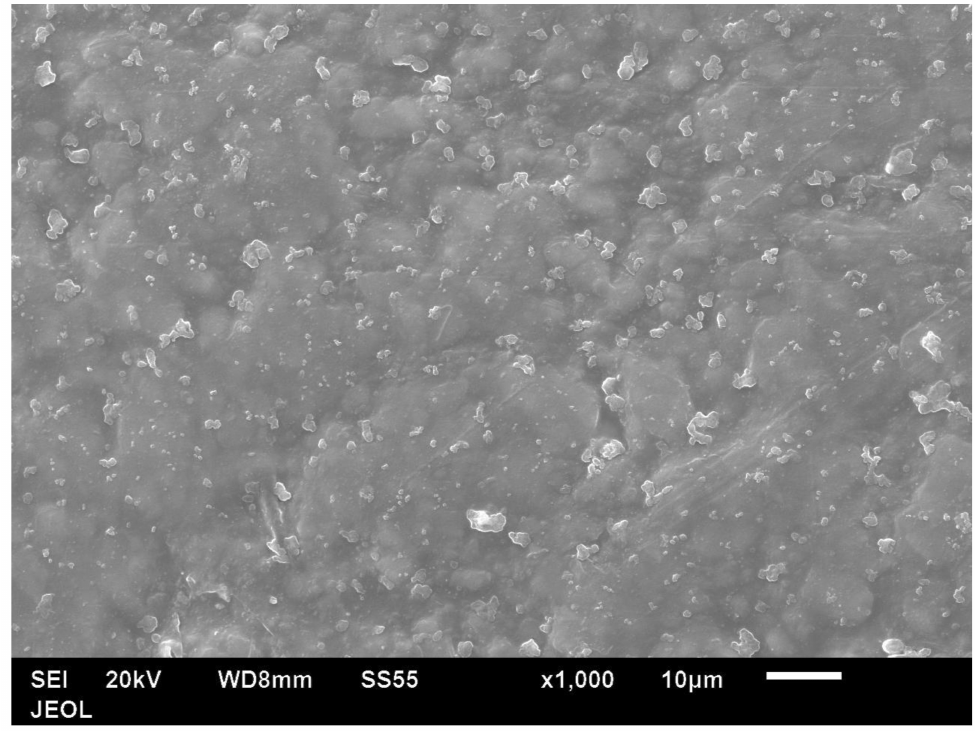
Figure 15. Low-magnification plan view of largest surface of the unfractured bar with 5 vol.% Al platelet–amorphous PET. Al platelets show a mostly planar orientation with respect to the principal face of the